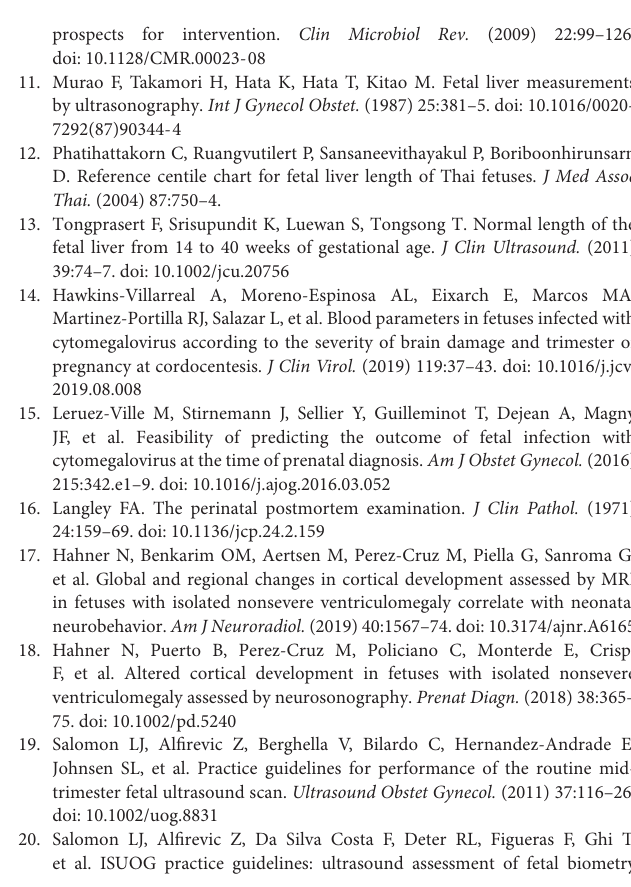
Supplementary Figure 1 | Fetal liver volume (FLV) and FLV-ratios according to the severity of brain abnormalities in CMV-infected fetuses (mild: n = 17, severe: n = 15). (A) FLV (cm 3 ), data presented as median (IQR: interquartile range: p25–p75). ∗ p -value determined with the Wilcoxon rank-sum test